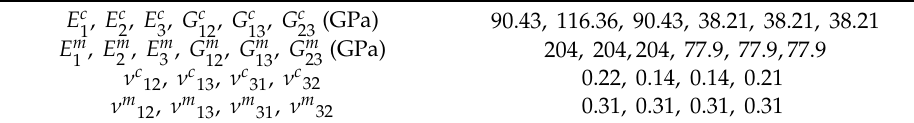
Table 1. Properties of the material alumina / nickel (Goli et al.